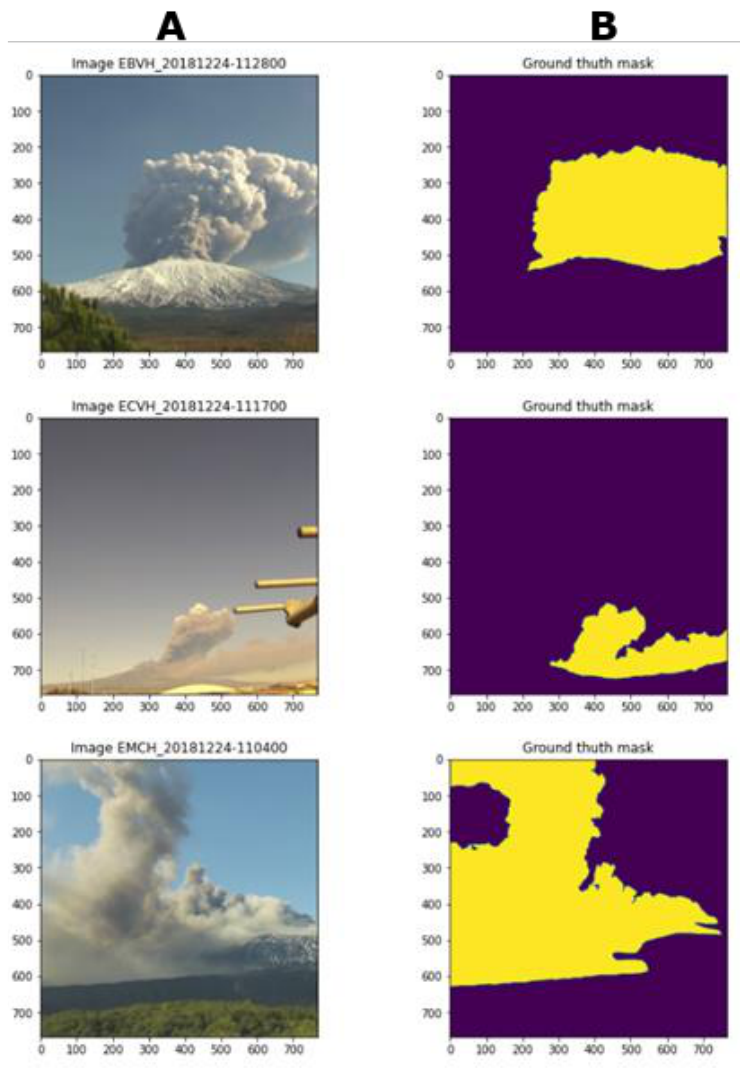
Figure 4. Examples of variable pairs (in ( A ) the real images are shown and ( B ) represents the ground truth mask).